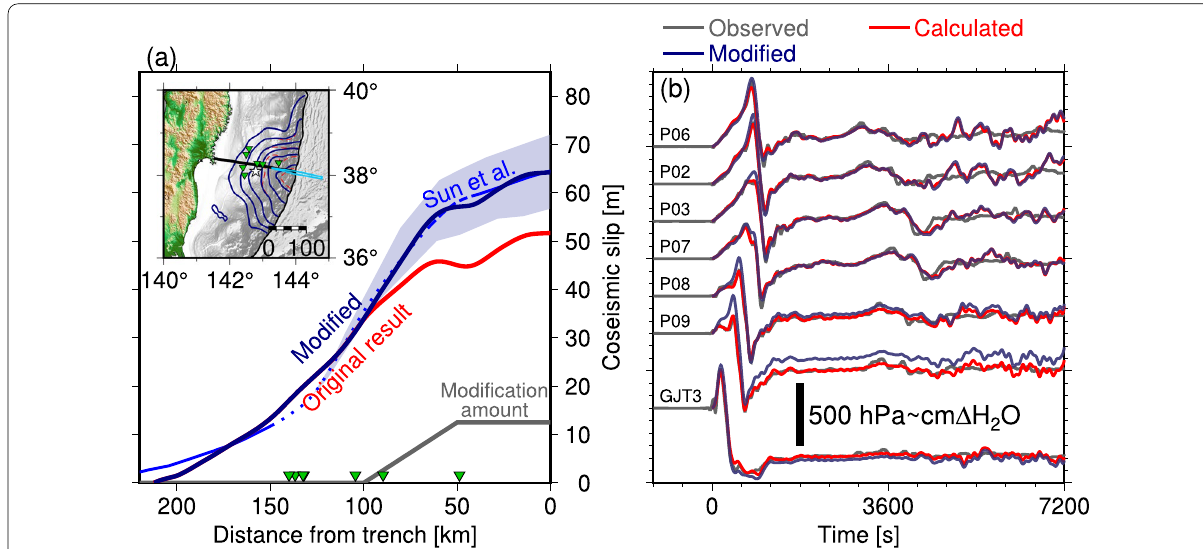
Fig. 8 Tsunami simulation using a previous slip model from Sun et al. (2017). a Comparison of the along-dip slip profile of the present model (red), the model in which the slip amount is modified (dark blue), and the slip profile estimated by Sun et al. (2017) (blue). The amount of modification of the slip is indicated by the gray line. The colors, shading, triangles, and bathymetry description are the same as in the legend of Fig. 7a. b Comparison between the observed (gray) and simulated waveforms (colored) at representative